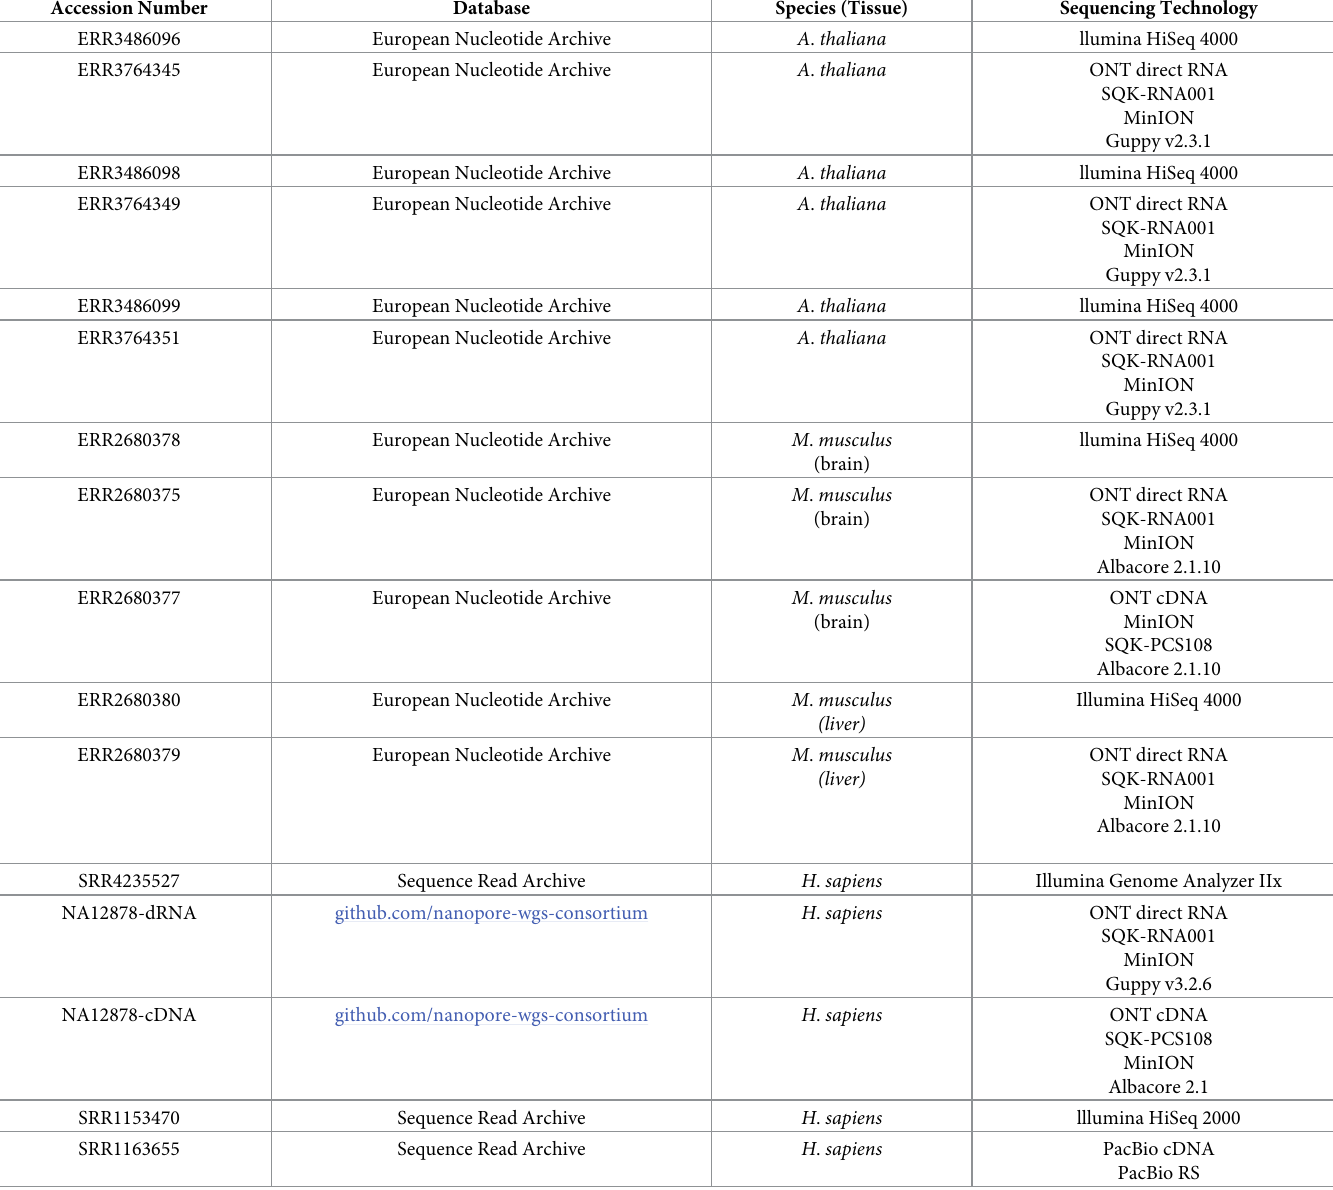
Table 1. Availability of real RNA-seq datasets and descriptions of sequencing technology used including chemistry and basecaller version for ONT